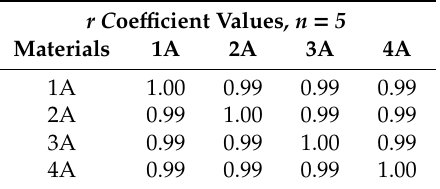
Sample destroyed before the 60 MPa load level was reached Table 9. Correlations matrix of creep module of elasticity on load 1 (20 MPa of